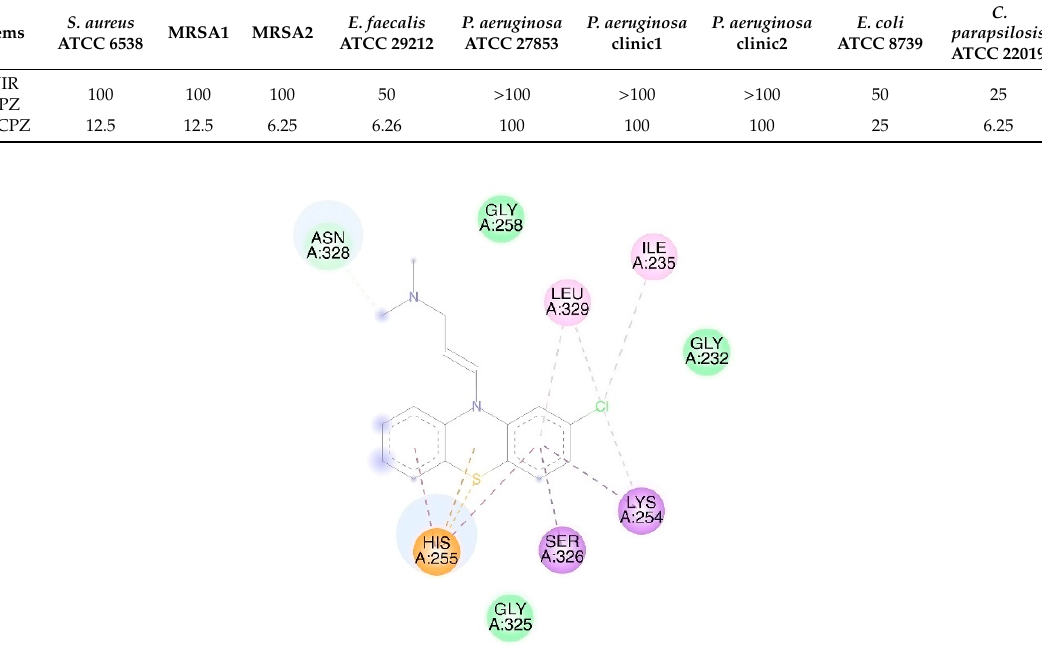
using Discovery studio visualizer [47]. Lys254 and His255 are AA in common with AA from theactive